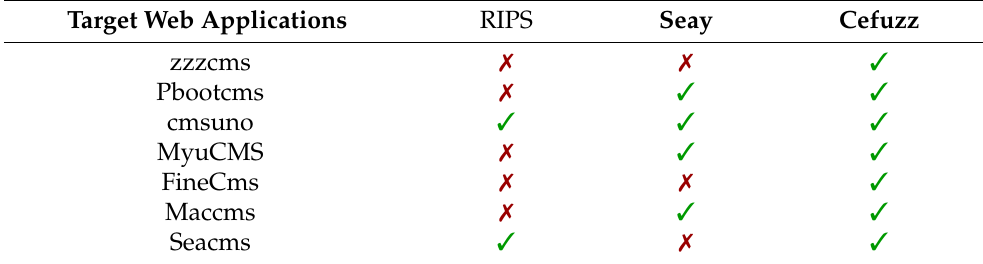
Table 3 . Known vulnerabilities verification experiment